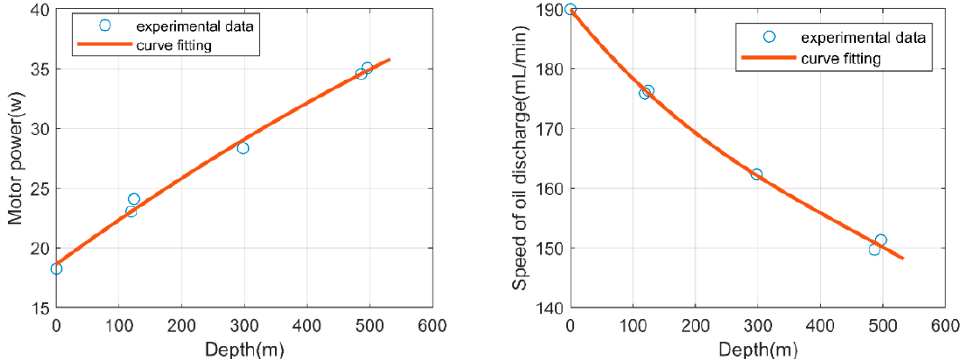
Figure 4. Motor power and speed of oil discharge curves at different depths.